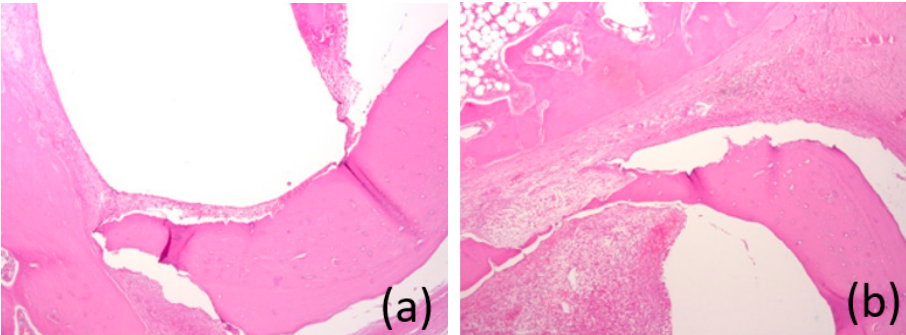
Figure 17. ( a , b ) Images of the histological preparations of a sample removed after 6 months and stained with hematoxylin and eosin, using a microscope at ×50 magnification.